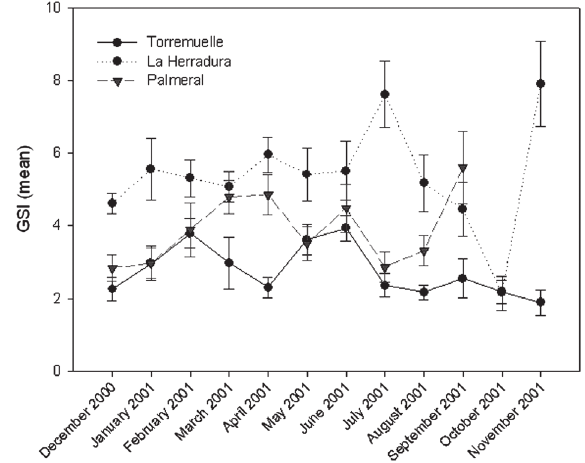
Fig . 4 . – temporal trends of the Gonadosomatic Index at the three sampling localities. the values are mean and standard